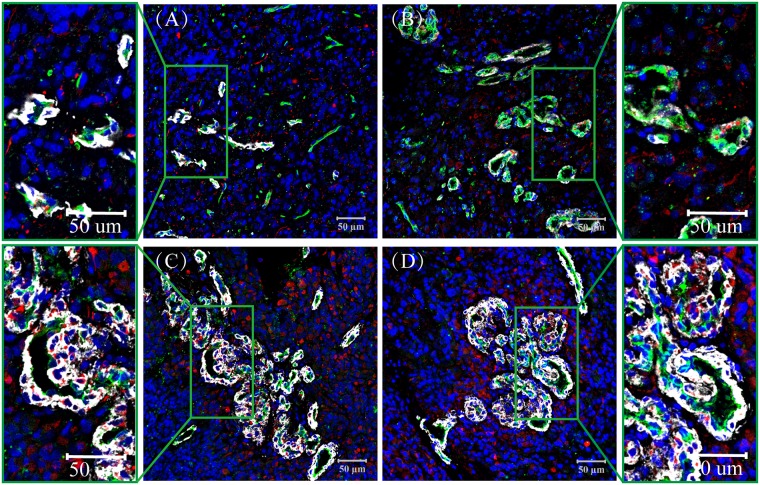
Nestin/α-SMA/CD34 Expression in Glioblastoma, α-SMA (Purple), Nestin (Red), CD34 (Green).(A) microvascular sprouting (MS), some of the CD31 positive blood vessels express α-SMA, but others do not; (B) vascular cluster (VC), many α-SMA positive cells surround VC; (C) vascular garland (VG), where most of the α-SMA positive cells accumulated around the blood vessels; (D) glomeruloid vascular proliferation (GVP), a large number of α-SMA positive cells were detected in the periphery of vessels, but fewer were present in the avascular area. Some Nestin positive cells co-expressed α-SMA. Nuclei are always counterstained with DAPI (Blue).